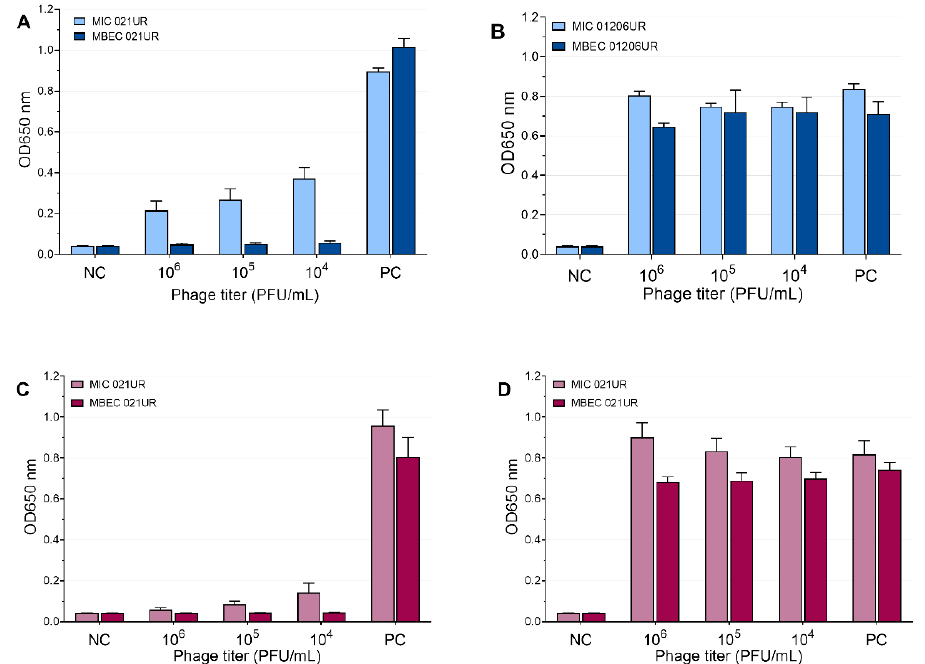
Figure 6. Ses and Intesti phage effects at different concentrations represented as mean values. ( A ) MIC and MBEC in 021UR by SES; ( B ) MIC and MBEC in 01206UR by Ses; ( C ) MIC and MBEC in 021UR by Intesti; ( D ) MIC and MBEC in 01206UR by Intesti.